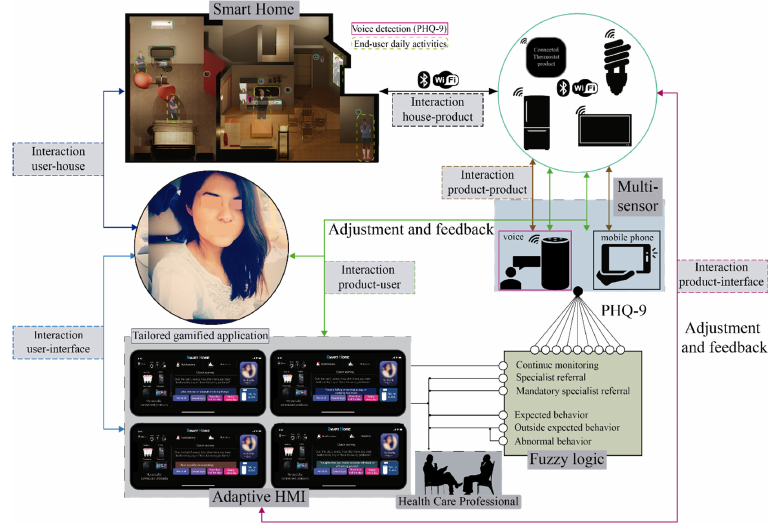
Figure 3. Smart Home Structure considering the PHQ-9 and the inclusion of Alexa.